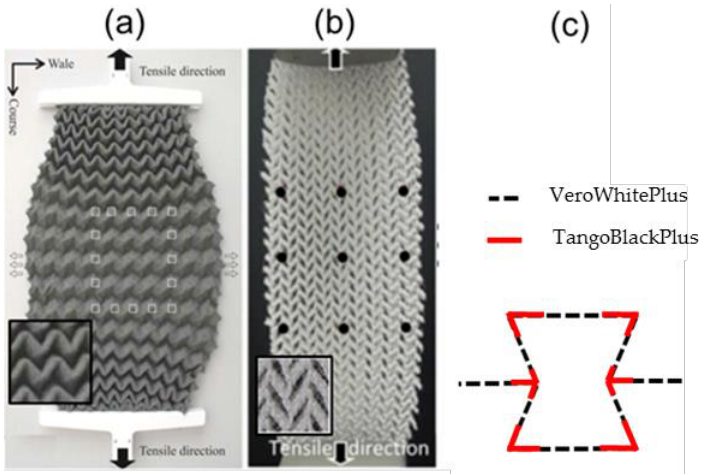
Figure 4. ( a ) Points marked on auxetic warp-knit fabric under tension [36]; ( b ) NPR effect of a weft knit fabric subject to extension [29]; ( c ) Dual-material auxetic metamaterial.